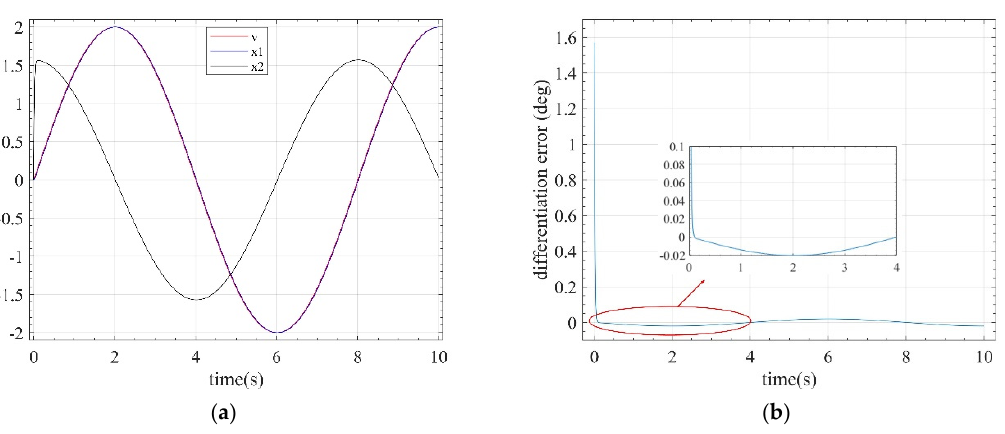
Figure 2. ( a ) Tracking and differentiation performances with a sine input and ( b ) differentiation error